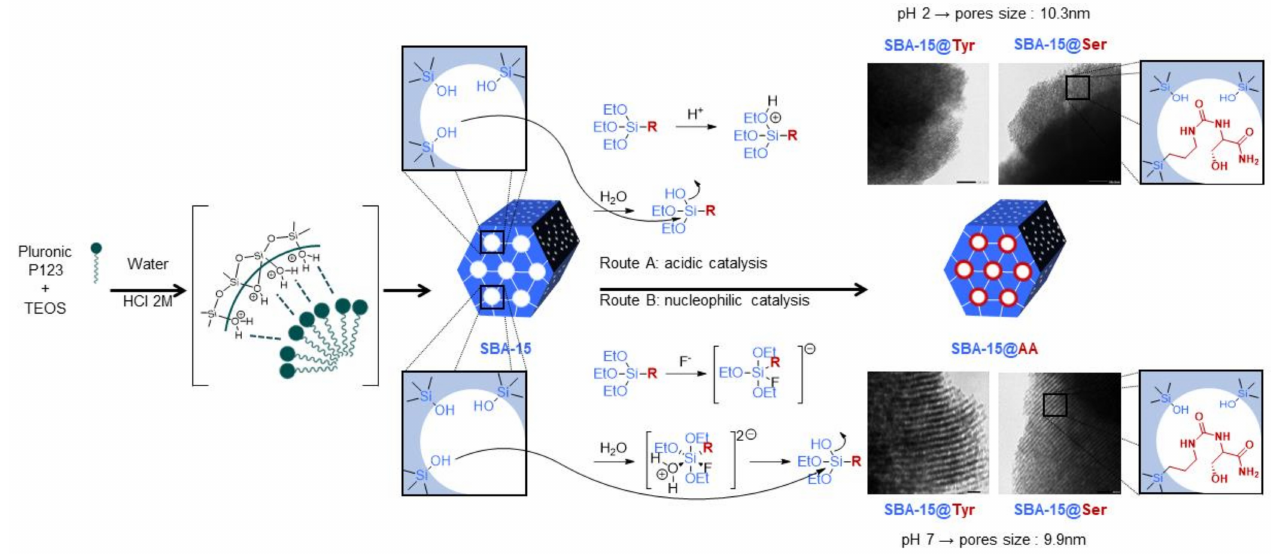
Figure 5. Schema of the SBA-15 functionalization with Si-AA-NH 2